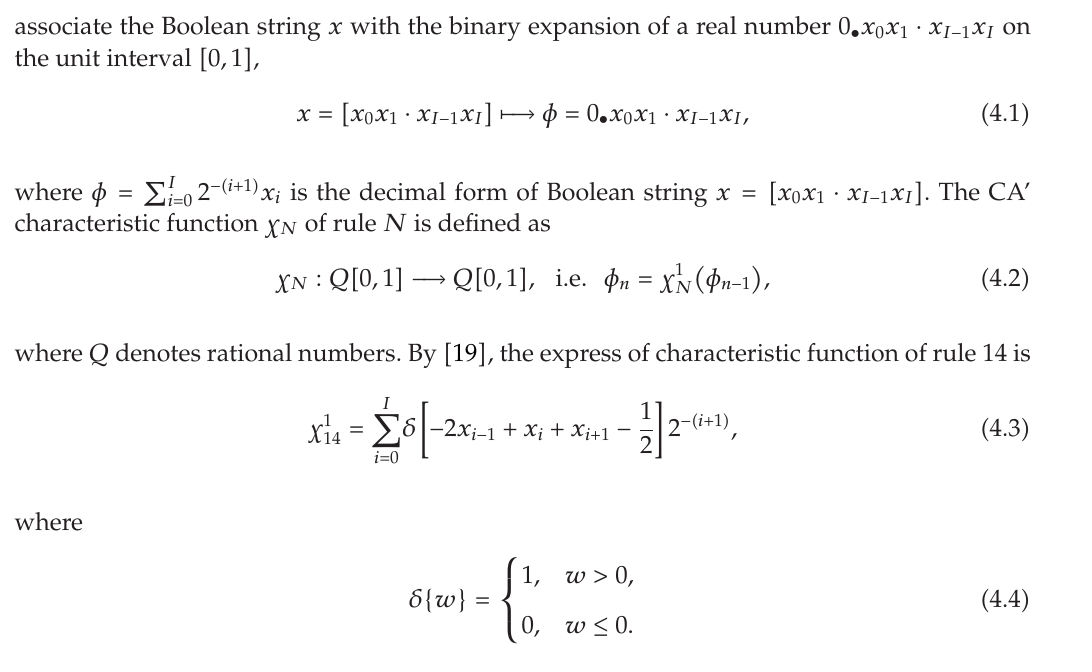
associate the Boolean string x with the binary expansion of a real number 0 • x 0 x 1 · x I − 1 x I